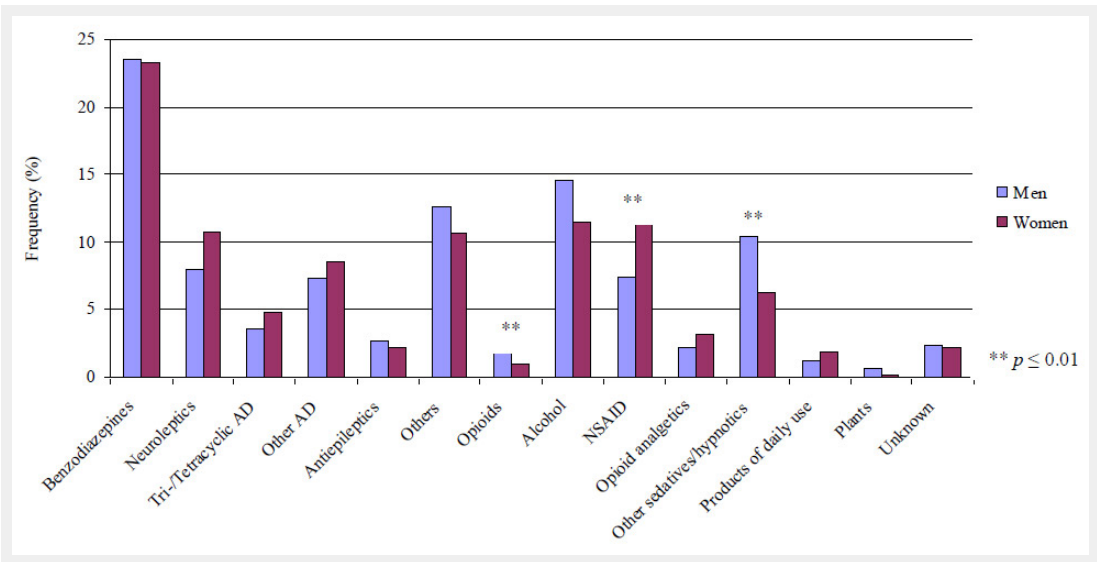
Figure 2 Distribution of used drugs in suicide attempts (multiple nominations). NSAID = nonsteroidal anti-inflammatory drug; AD =